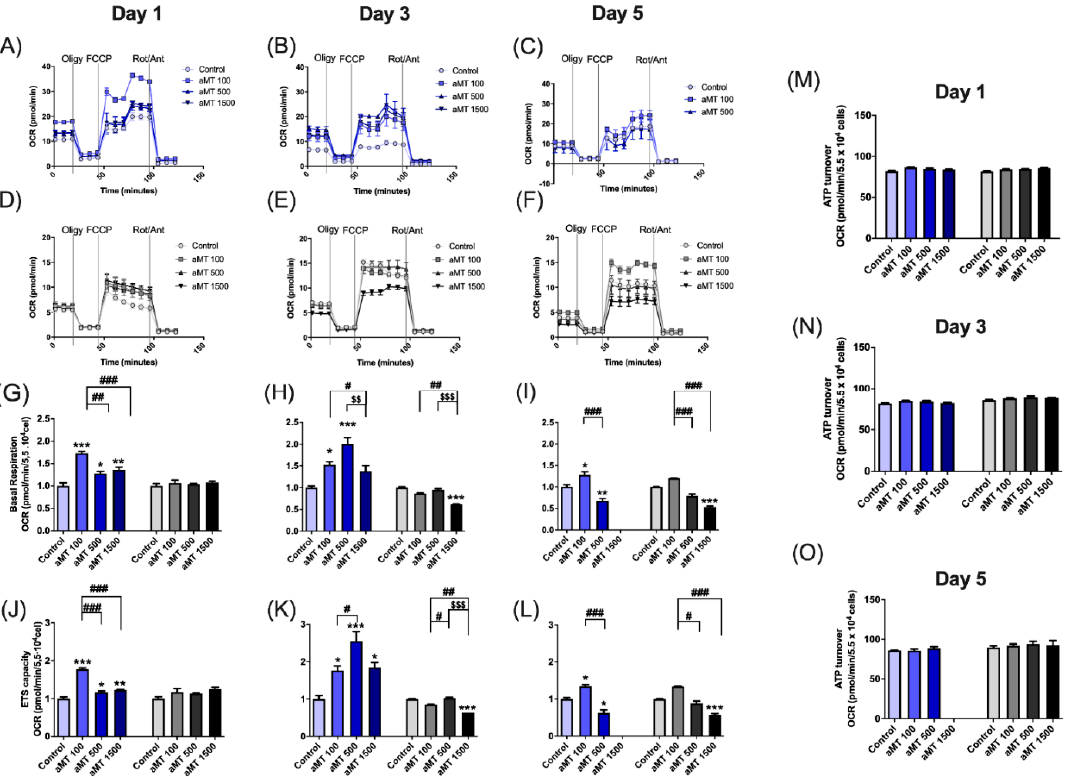
Figure 2. Effect of melatonin on mitochondrial respiration in HNSCC cell lines Cal-27 (in blue) and SCC-9 (in black and grey). Oxygen consumption rate (OCR) after 1 day ( A , D ), 3 days ( B , E ), and 5 days ( C , F ) of melatonin treatment, basal respiration ( G – I ), maximal respiratory capacity (ETS) ( J–L ) and ATP turnover ( M–O ). Treatment groups include vehicle (control) and melatonin (aMT) at concentrations of 100 µM, 500 µM, and 1500 µM. Data for aMT 1500 group are not shown at day 5 because most cells died. n = 6 per group. Data are presented as mean ± SEM. * p < 0.05, ** p < 0.01, *** p < 0.001 vs. control; # p < 0.05, ## p < 0.01, ### p < 0.001 vs. aMT 100 µM group; $$ p < 0.01, $$$ p < 0.001 vs. aMT 500 µM group.